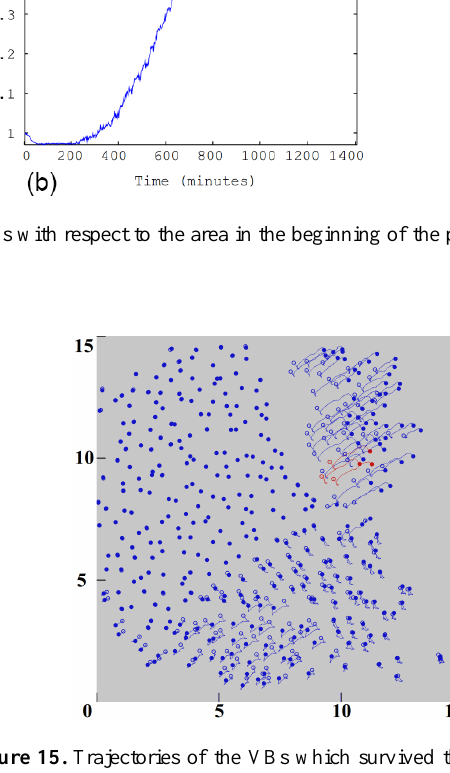
was a ≈ 7 . 5 × 10 − 6 m s − 2 in the time interval from 600 to 800